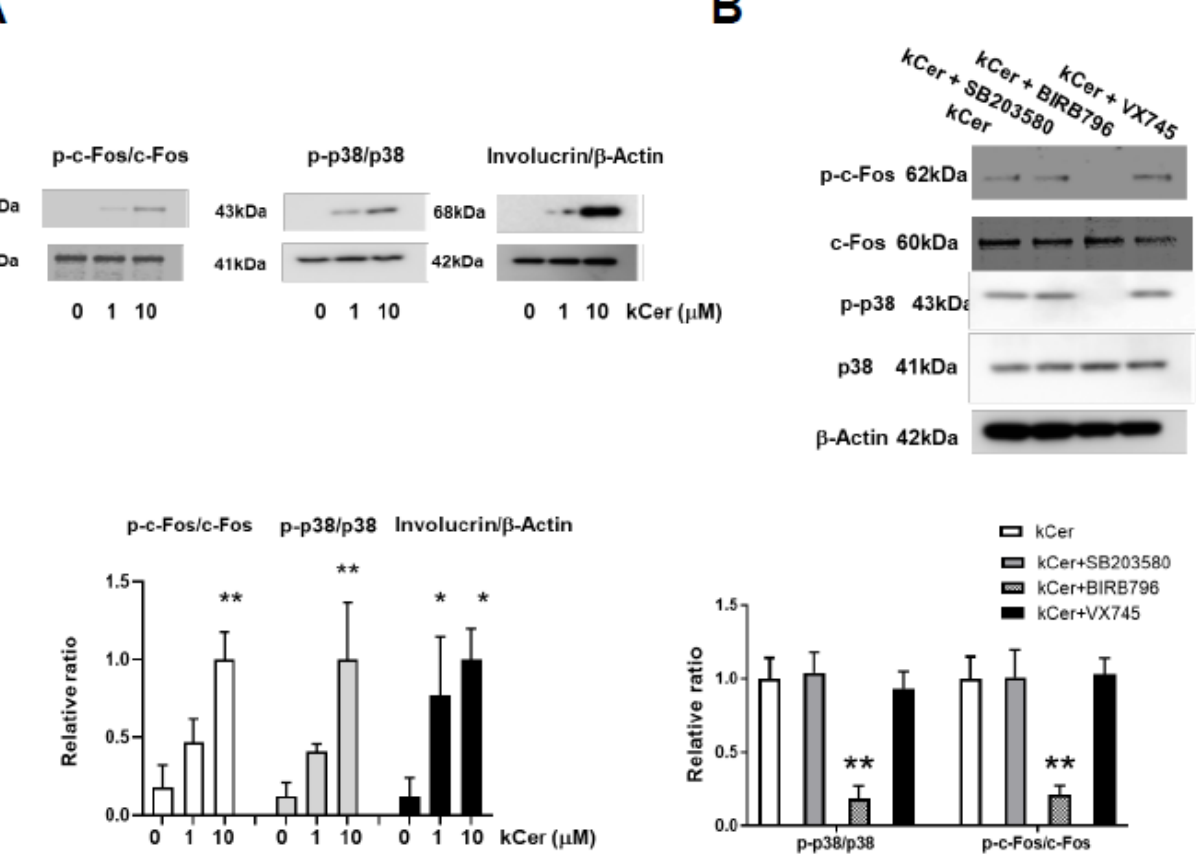
Figure 3. Western blot analysis of kCer-induced HaCaT cell differentiation and signaling pathway activation. ( A ) Effects of treatments (0, 1, and 10 µ M kCer) on cell protein (c-Fos, p-c-Fos, p38, and p-p38) expression were measured by Western blot analysis. The blotted bands were analyzed by Image J and graphed as shown below. Bars represent the relative ratios of p-c-Fos/c-Fos, p-p38/p38, and involucrin/ β -Actin. ( B ) Effects of treatment with 10 µ M kCer treatment ± 1.0 µ M of the p38MAPK inhibitor SB203580 (p38 α /p38 β ), BIRB796 (p38 α /p38 β /p38 γ /p38 δ ), or VX745 (p38 α /p38 β /p38 δ ), respectively. Cell lysates were subjected to immunoblot analysis, followed by detection of p-c-Fos, c-Fos, p-p38, p38, and β -Actin. Immunoblot bands were analyzed by Image J, and the relative ratios of p-p38/p38 and p-c-Fos/c-Fos are graphed below. Data are presented as means ± SD ( n = 3, ** p < 0.01, * p < 0.05).